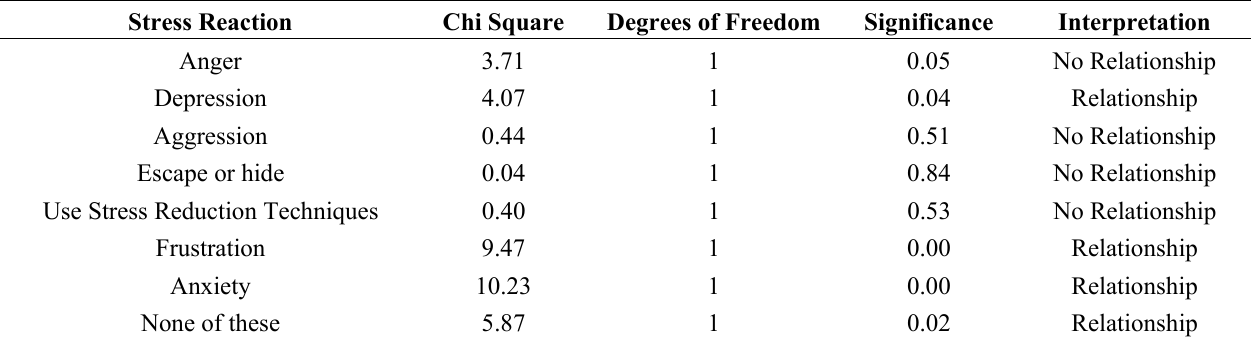
Table 9. Gender effects on stress